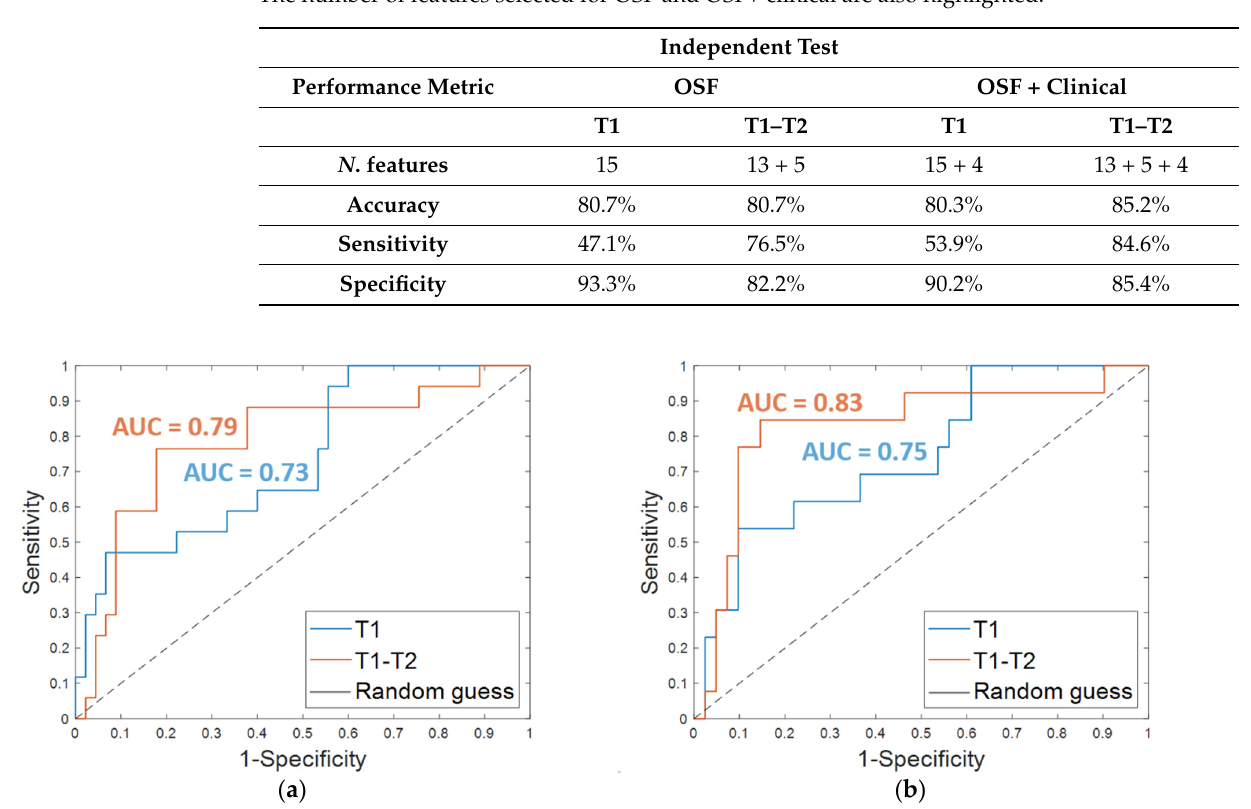
Table 3. Summary of the performances of the breast cancer recurrence prediction models on the independent test in terms of accuracy, sensitivity, and specificity, using the Optimal Subset of Features (OSF) also combined with the clinical features (OSF + clinical), respectively. The features were selected for the exams at timepoint T1 alone or at timepoints T1–T2 simultaneously (original model). The number of features selected for OSF and OSF+ clinical are also highlighted.